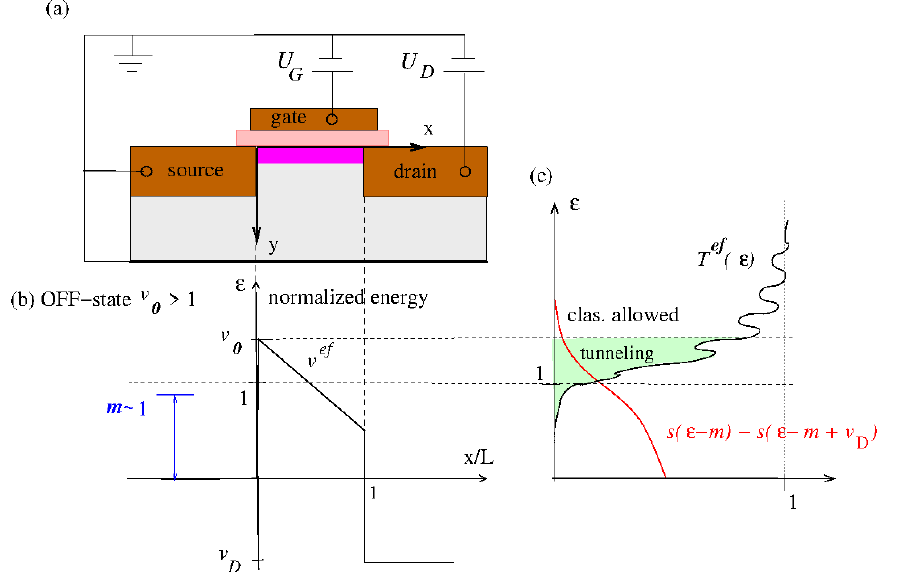
Figure 1. ( a ) N-type bulk nano-FET with applied gate voltage U G and drain voltage U D ; ( b ) normalized effective potential v ef ( x ) along the conduction channel with maximum barrier height v 0 ; ( c ) schematic plot of the factor s ( (cid:101) − m ) − s ( (cid:101) − m + v D ) in (1) containing the normalized supply functions (red) and the current transmission function T ef ( (cid:101) ) (black). Shaded green: tunneling part of the current transmission (see also Figure